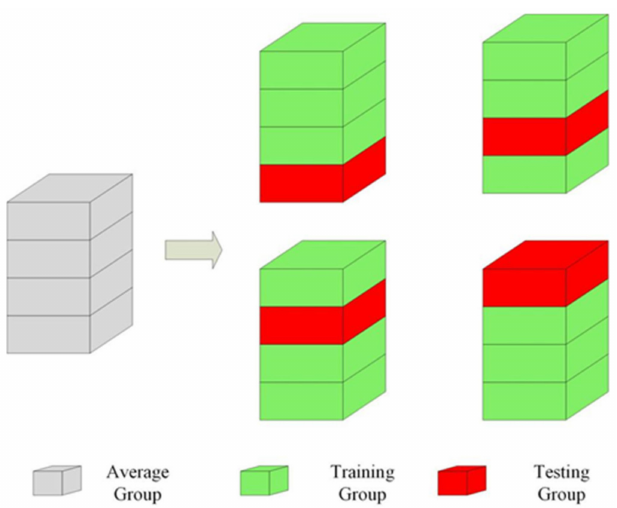
Figure 5. Scheme diagram showing cross-validation used in the